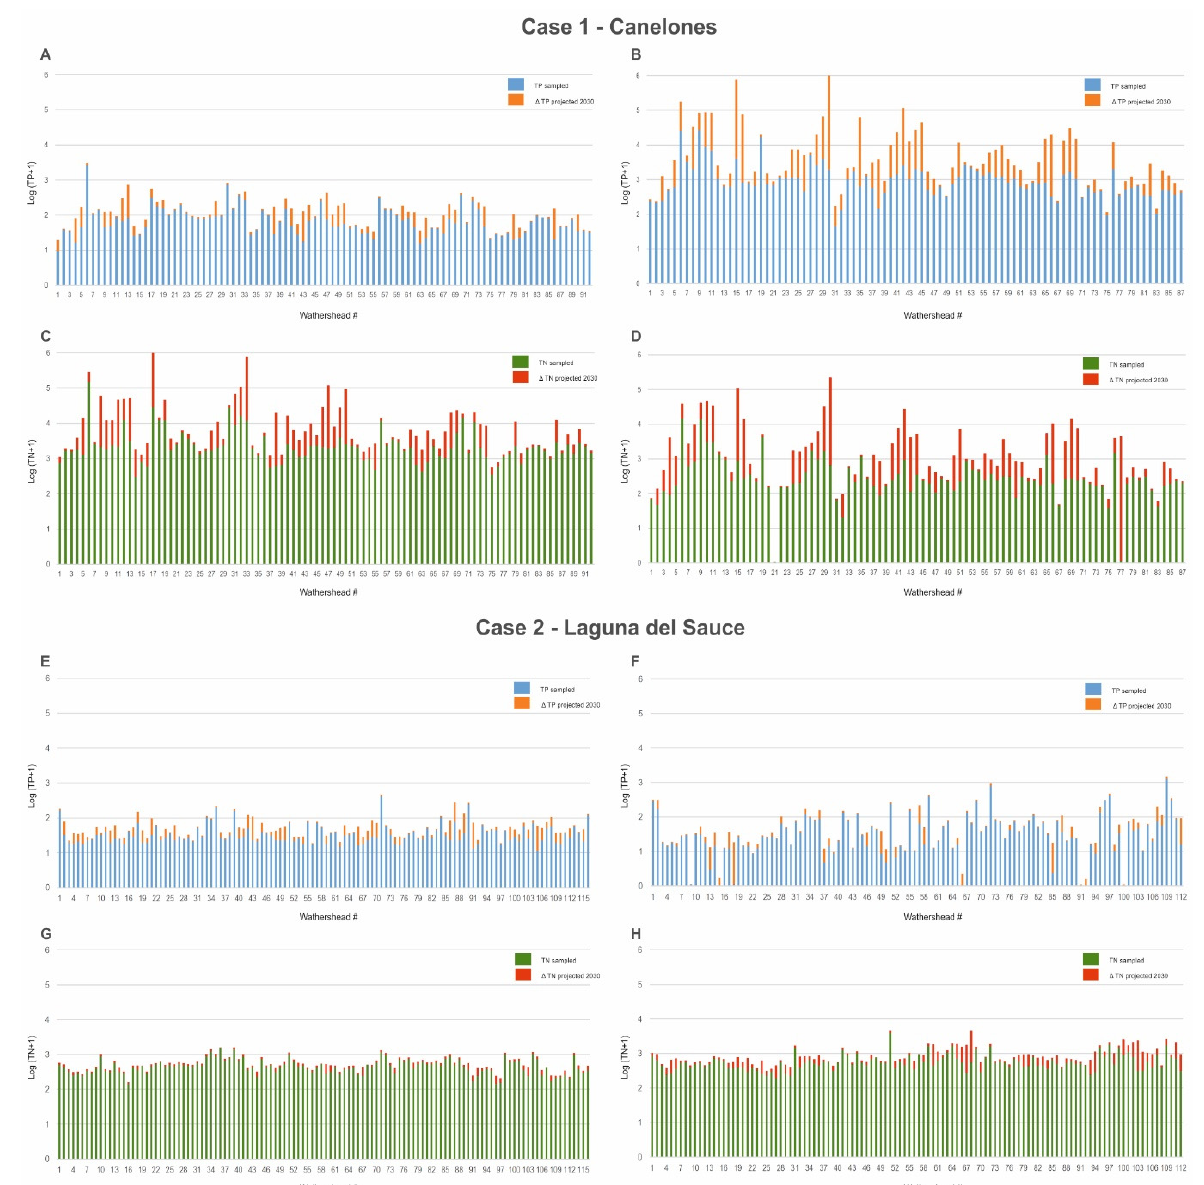
Figure 2. Case 1 (Canelones). Total phosphorus (TP, µ g/L) concentrations (log PT + 1) were sampled, and their difference ( ∆ ) projected for 2030. During winter–spring (WS) ( A ) and summer–autumn (SA) ( B ) Total nitrogen (TN, µ g/L) concentrations (log NT + 1) were surveyed and projected for the 2030 scenario in WS ( C ) and SA ( D ) Case 2 (Laguna del Sauce). TP concentrations (log PT + 1) sampled, and its difference ( ∆ ) projected for the 2030. During WS ( E ) and SA ( F ). TN concentrations (log NT + 1) surveyed and projected for 2030 scenario in WS ( G ) and SA ( H ).